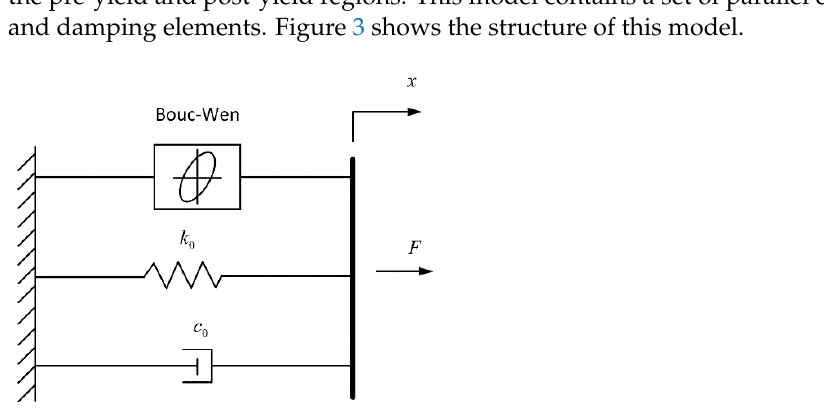
Figure 3. The structure of the Bouc–Wen model [18].